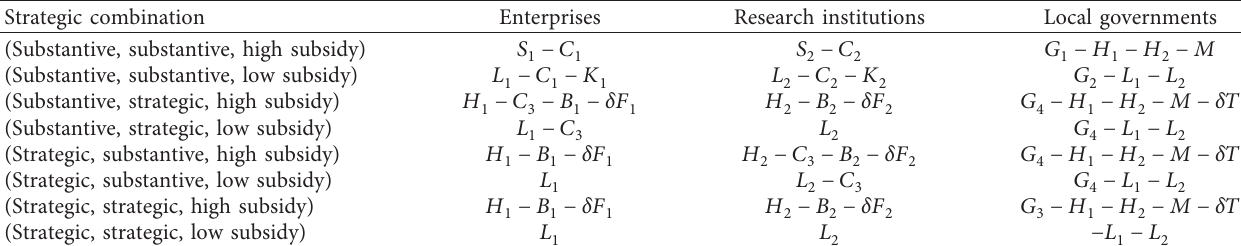
Table 1: Payoff matrix of enterprises, research institutions, and local